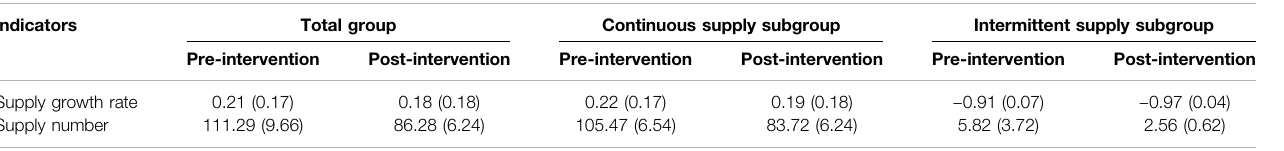
TABLE 2 | Descriptive statistics of two indicators ( N (cid:1) 56 quarters).